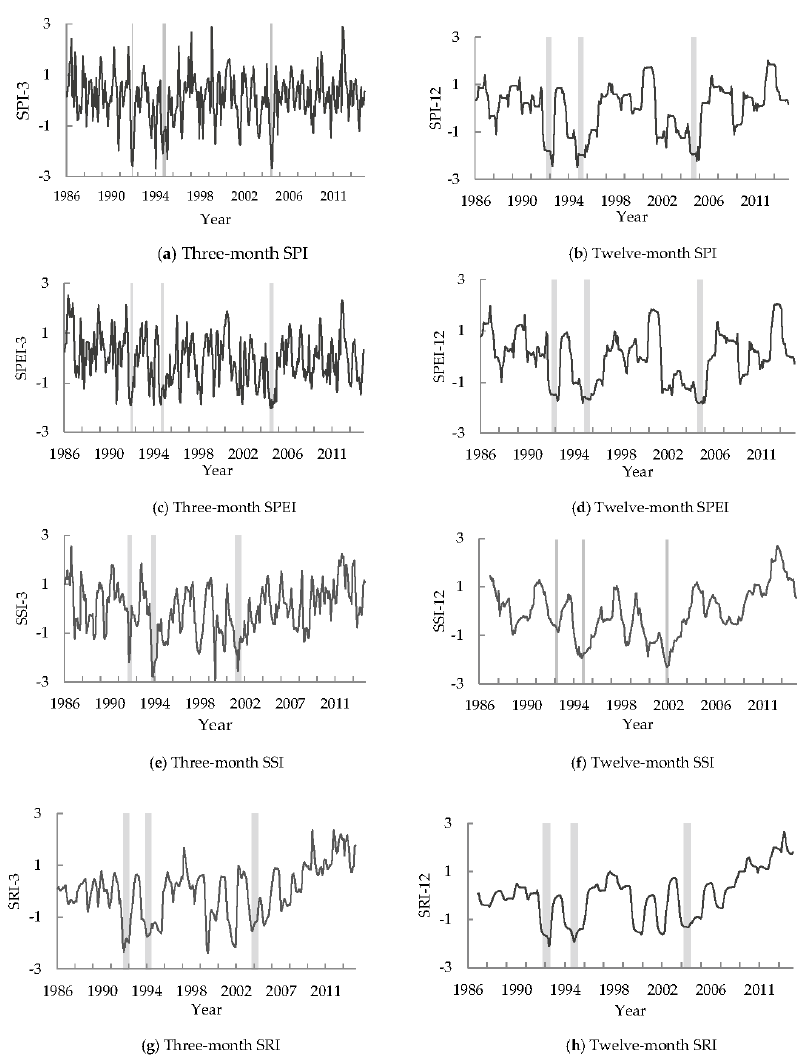
Figure 4. ( a – h ) Temporal variation of droughts based on different indices at 3 and 12 month aggregates in UKRB. Grey lines show major drought events captured by the indices.